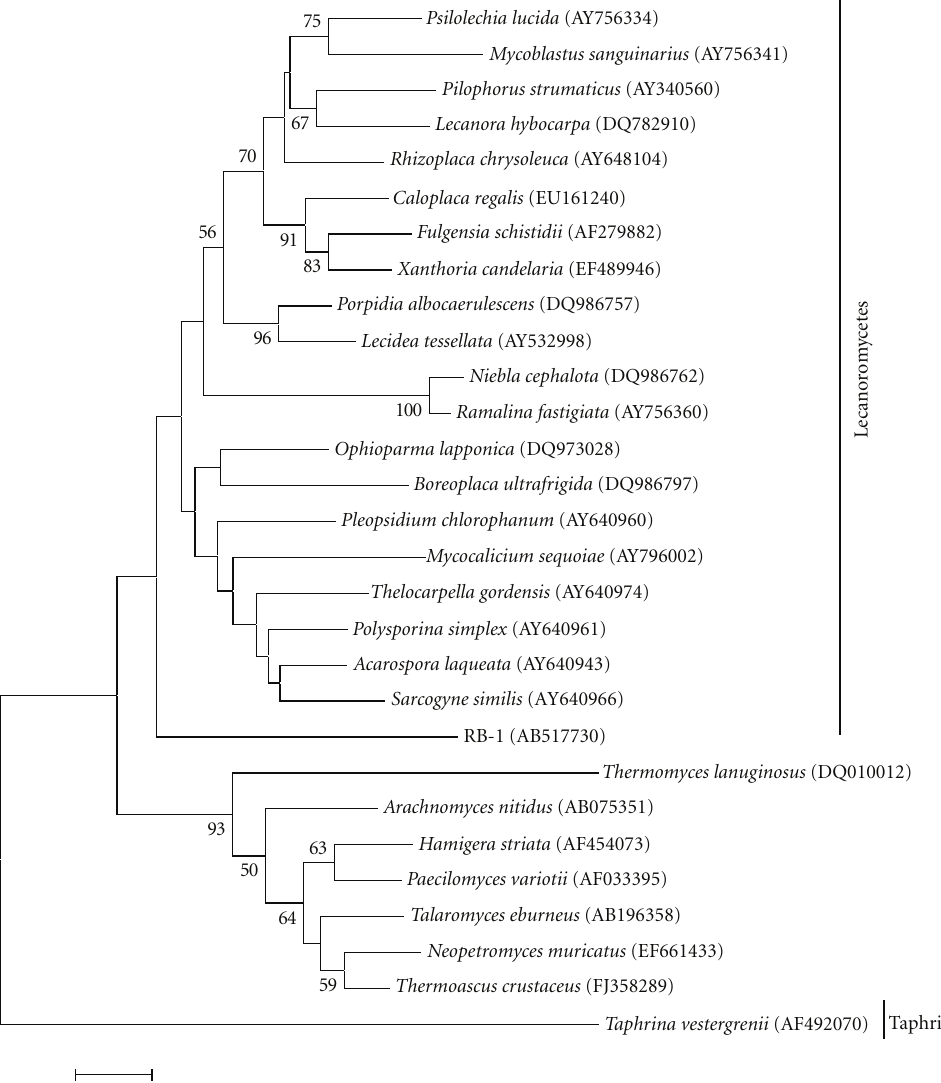
Figure 3: Phylogenetic tree for RB-1 constructed by the neighbor-joining method on the basis of the D1-D2 sequences retrieved from the DDBJ/GenBank/EMBL databases. DDBJ/GenBank/EMBL accession numbers of retrieved sequences are indicated in parentheses. The Bootstrap values based on 1000 replications are given on the nodes as percentages above 50%. Taphrina vestergrenii was used as the outgroup. Bar: 0.02 substitutions per nucleotide